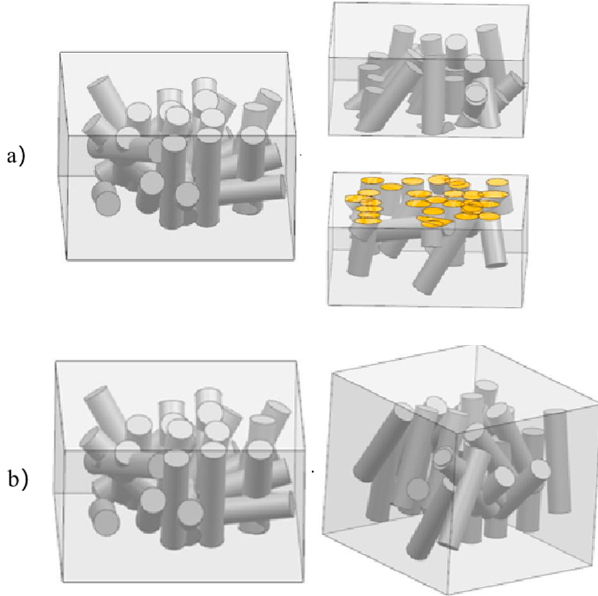
Figure 13. The schematic diagrams of the deformation of the original squeeze casting: ( a ) Aluminum matrix composites during tension; ( b ) Aluminum matrix composites during